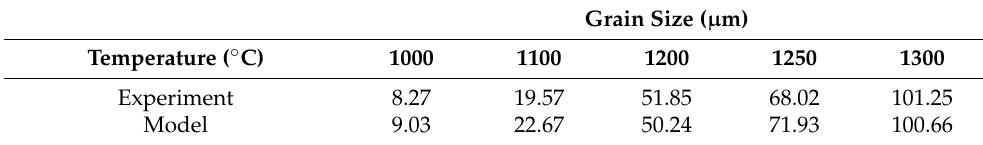
Table 2. The grain size of experiment and model.